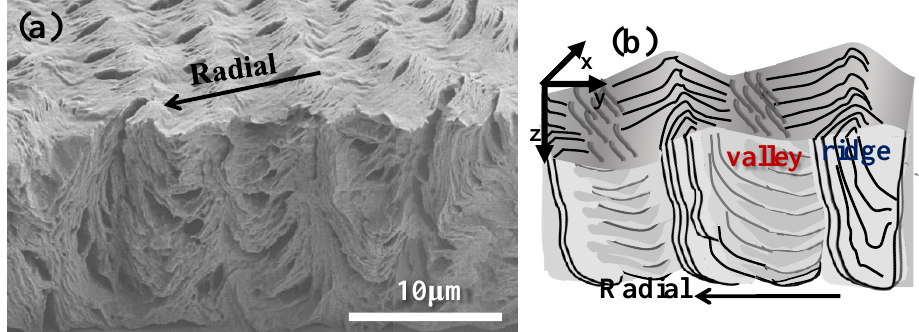
Figure 5. ( a ) SEM graph of a radial fracture surface of PBA/PEO (90/10) crystallized at 30 °C, and ( b ) schematic illustrations for correlation between the interior lamellae and top-surface ring bands.